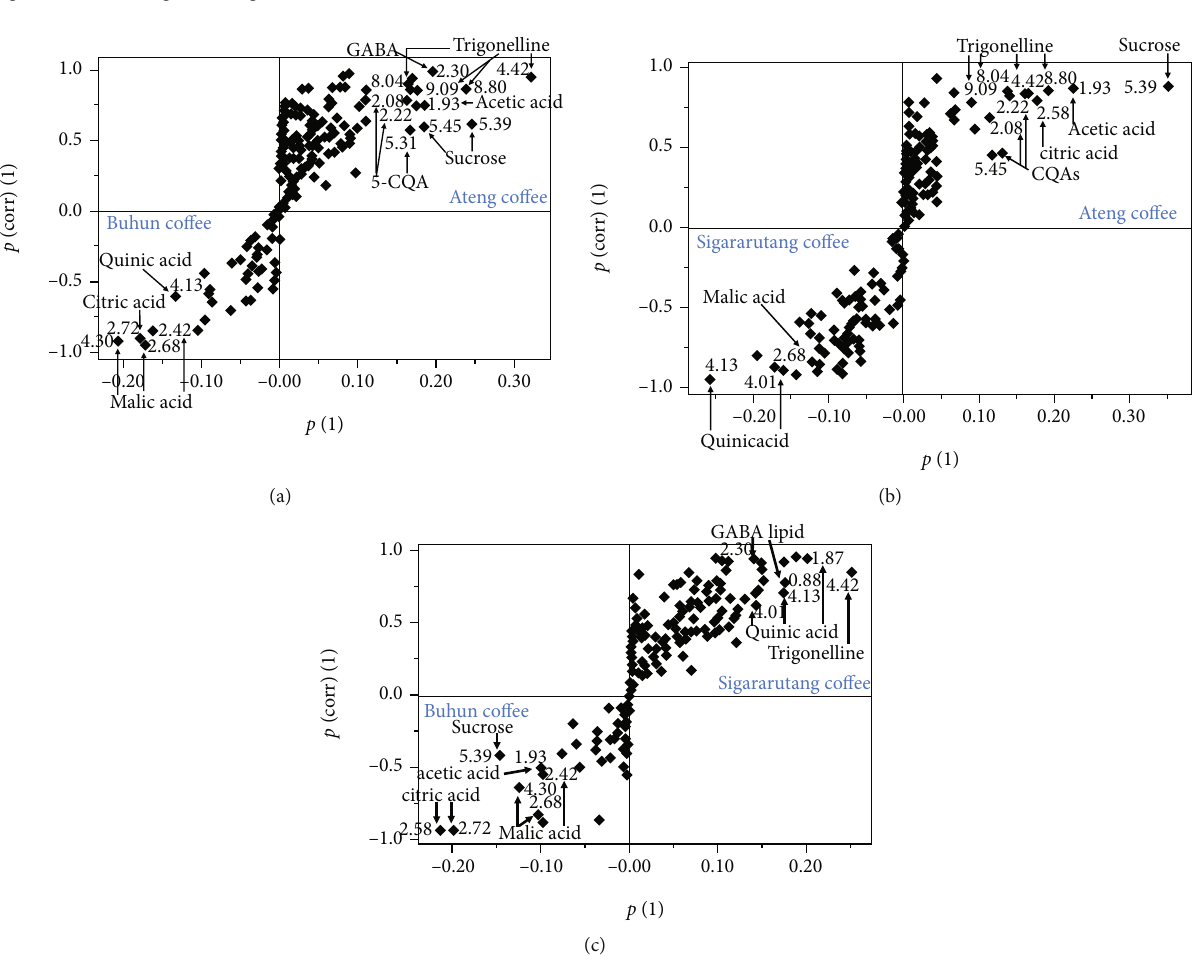
Figure 3: Multivariate data analysis computed for the green beans of the 3 Indonesian arabica co ff ee varieties. (a) PCA score plot separated buhun co ff ee from the others. (b) PLSDA score plot successfully classi fi ed the co ff ee samples based on their varieties. (c) PLSDA loading plot revealed the important buckets contributing to the classi fi cation. (d) HCA plot showed the lineage relationship within the co ff ee samples. A: ateng; B: buhun; S: sigararutang.